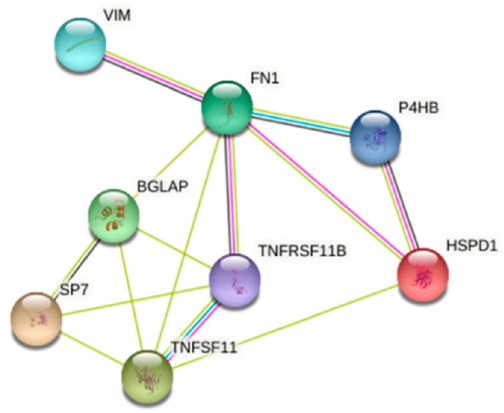
Figure 4. STRING analysis of protein interaction networks. Interactions of identified proteins were mapped by searching STRING database version 10.5 with a confidence cutoff of 0.4. In the resulting protein association network, proteins are presented as nodes connected by lines whose thickness represents the confidence level. Osteoblast differentiation-related genes BGLAP (OC), TNFRSF11B (OPG), SP7 (OSX), TNFSF11 (RANKL), and FN1 (fibronectin) were obtained from the qPCR data (Figure 3).